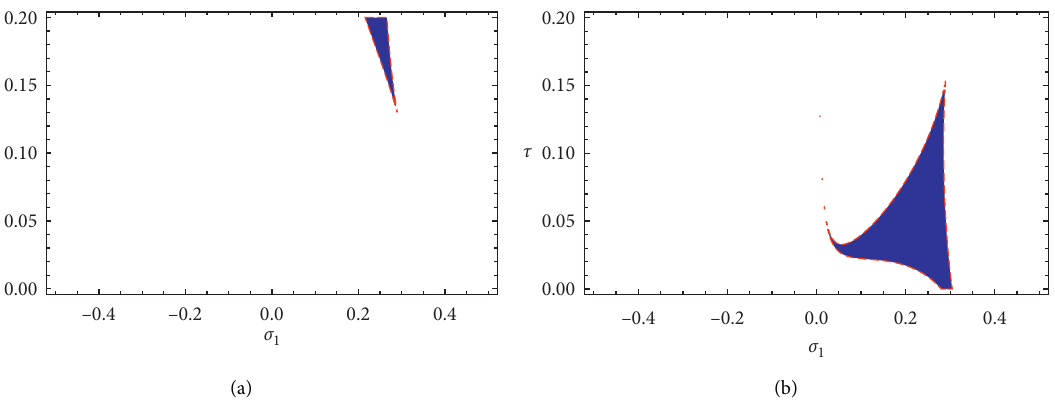
Figure 7: The system solution behavior in τ − σ